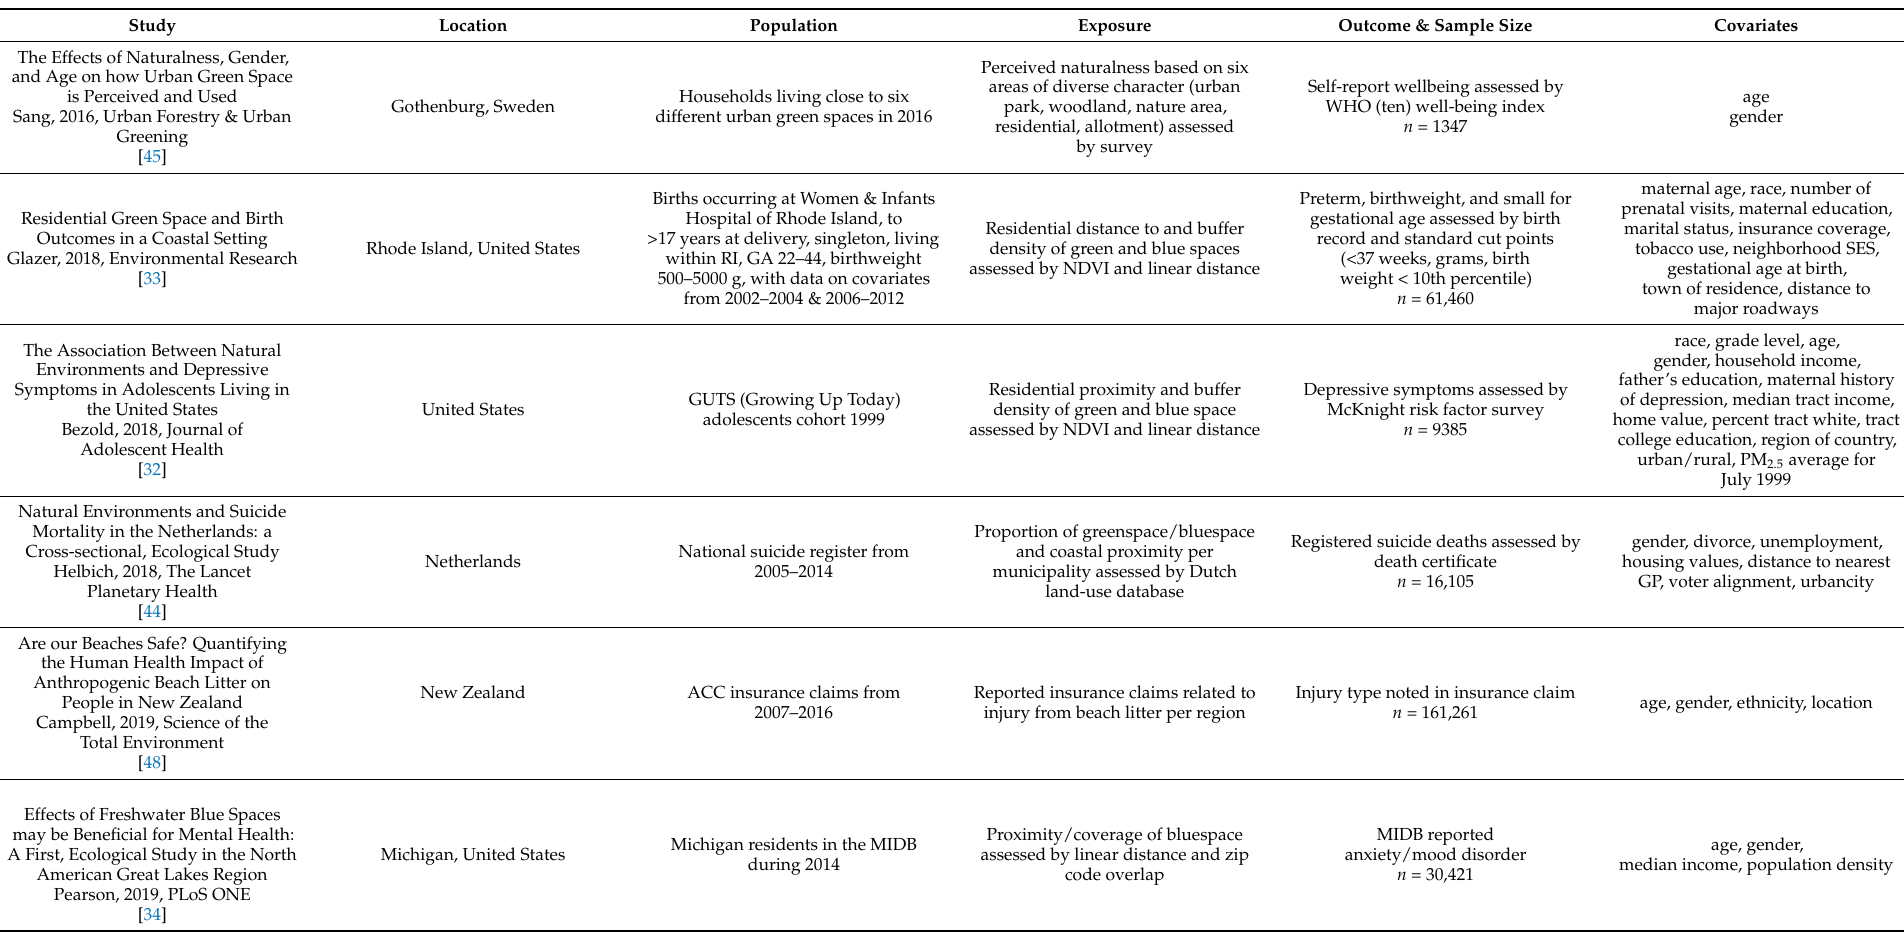
Table 1. Summary of data